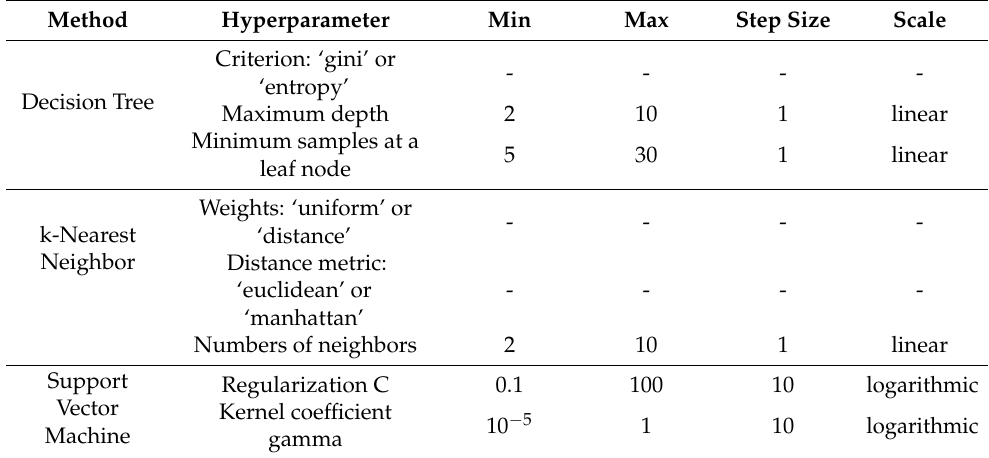
Table 2. Range of hyperparameters optimized with grid